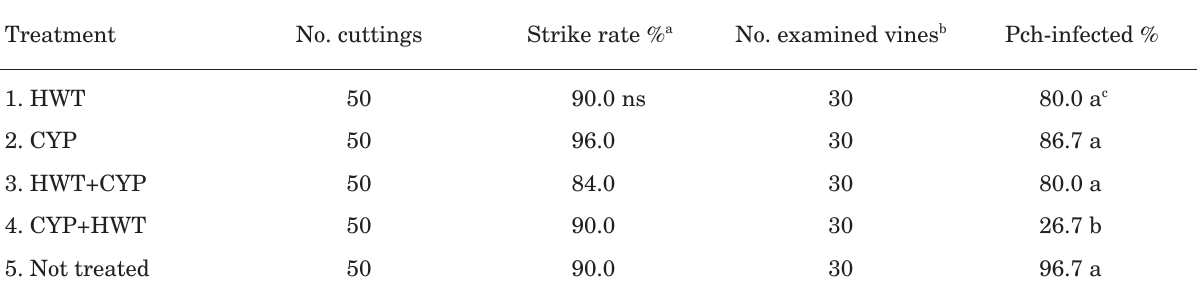
Table 4. Strike rate and Phaeomoniella chlamydospora (Pch) infection of artificially infected 1103P cuttings treated with hot water (HWT) and cyproconazole (CYP) in 2007.